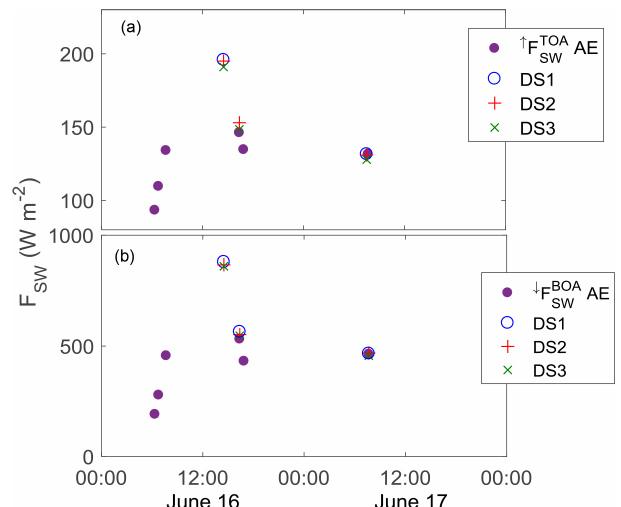
Figure 8. ARE profiles in the SW spectral range simulated using DS1 (blue line), DS2 (red line), and DS3 (green line) as aerosol input data in GAME for 16 June (a) and 17 June (b) . The purple dots represent the ARE provided by AERONET (AE) at the BOA and the TOA and the orange dot, the AERONET corrected for the surface albedo effect (AE-C; see text) ARE at the